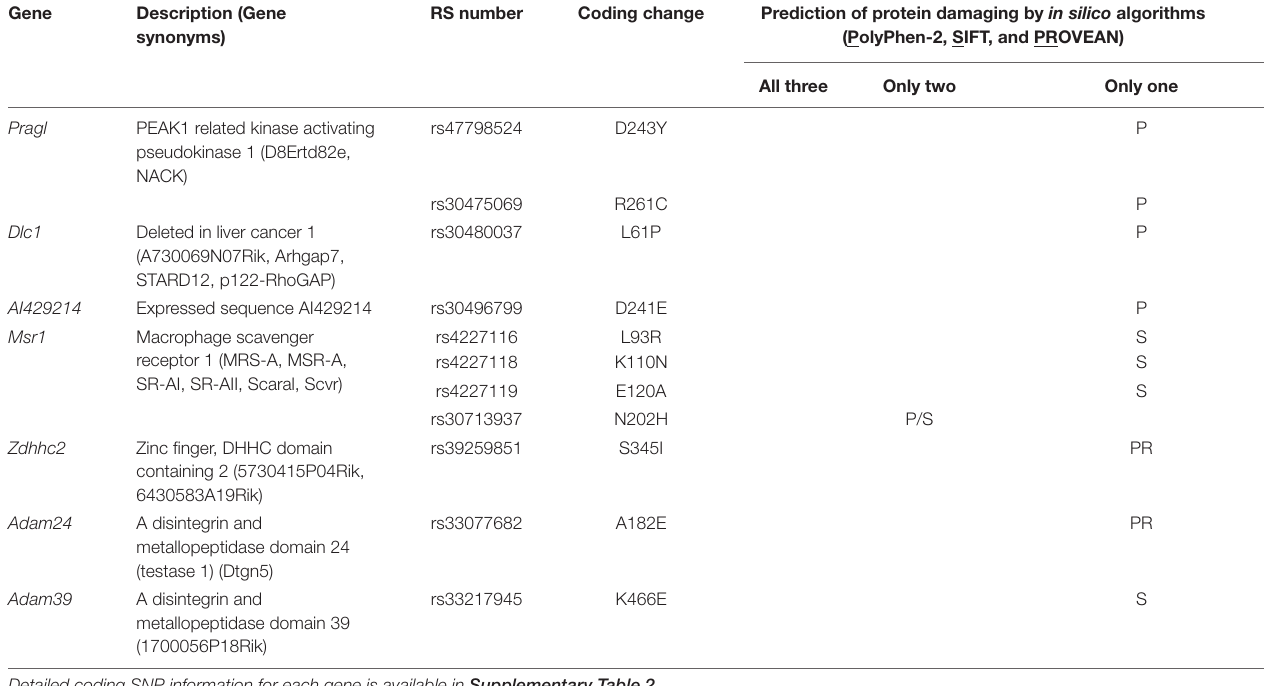
TABLE 2 | Candidate genes within the 1.5-LOD support interval that have coding SNPs predicted to be damaging for the C3H and WSB alleles. Gene Description (Gene synonyms)